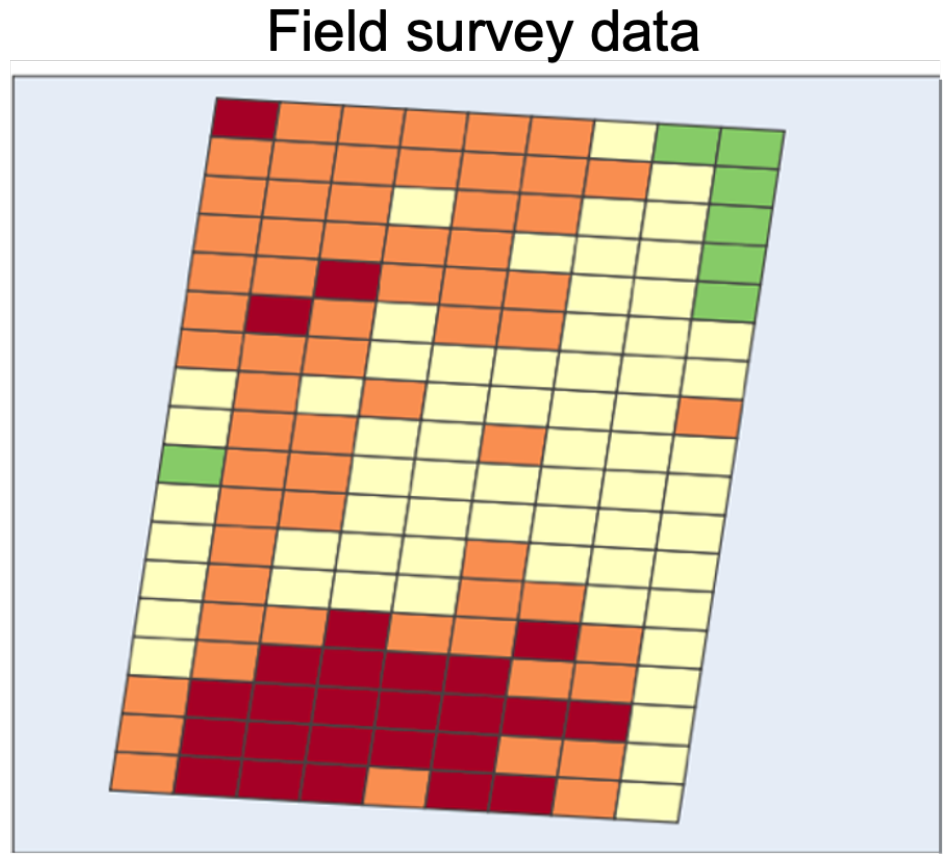
Figure 1. Example of field survey data collected for one field (dark green: absent; Light green: low; yellow: medium; orange: high; red: very